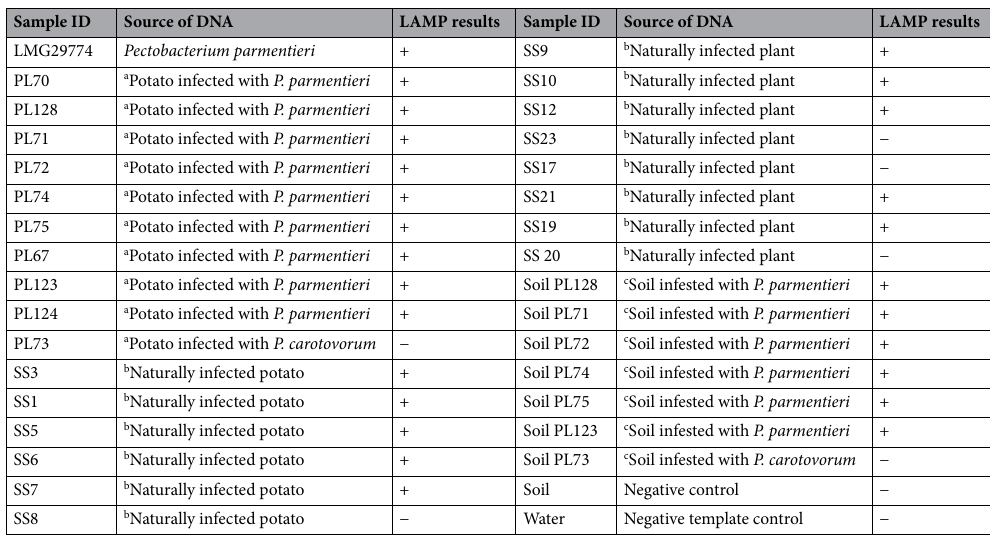
Table 4. Validation of Pectobacterium parmentieri loop-mediated isothermal amplification (LAMP) with naturally and artificially infected plant and infested soil samples. a Potato plants inoculated with Pectobacterium sp. in the greenhouse. Samples were taken from a previous study in our lab by Arizala et al. 30 . b Naturally infected potato plant samples were collected in 2019. These samples may have been infected with one or more pectinolytic bacterial species. c Potting soil infested with Pectobacterium sp. Samples were taken from a previous study in our lab by Arizala et al. 30 . ‘+’ is positive for P. parmentieri and ‘−’ is negative for P. parmentieri.